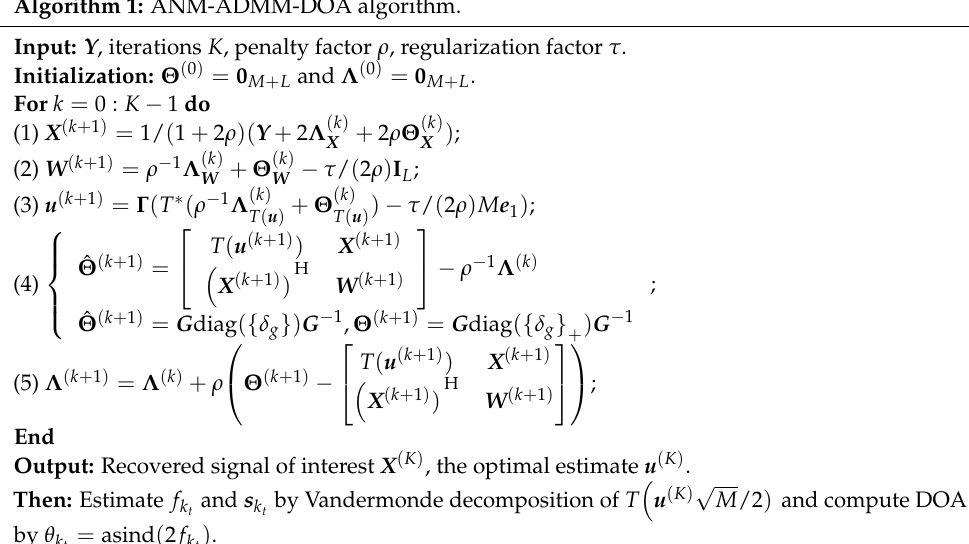
Algorithm 1: ANM-ADMM-DOA